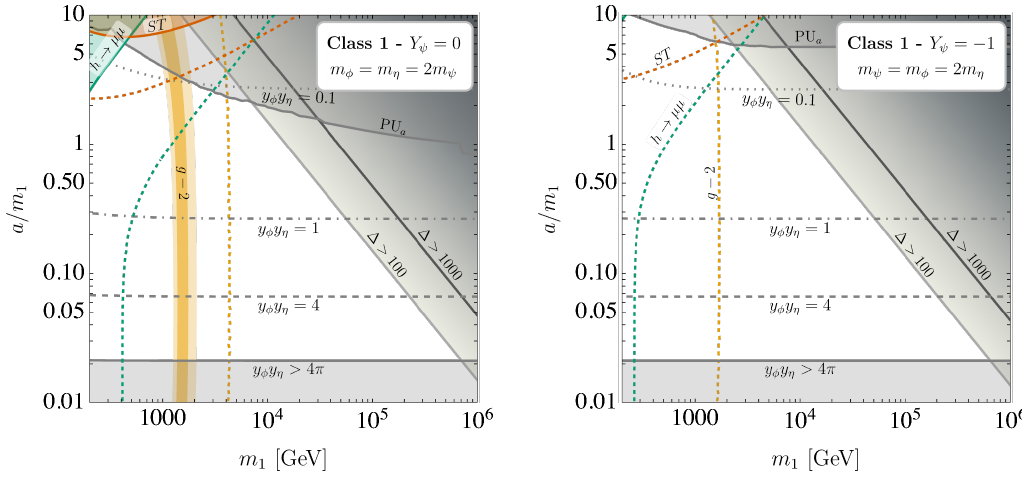
Figure 3 . Theoretical (grey) and experimental (coloured) constraints on the Class 1 benchmark models. The product of Yukawas required to reproduce the observed muon mass is shown by contours at y φ y η ∈ { 0 . 1 , 1 , 4 , 4 π } . The region where perturbative unitarity of the trilinear coupling is violated is indicated by PU a . The degree of fine-tuning is shown by contours at ∆ ∈ { 100 , 1000 } using the measure defined in [3]. The orange bands show the region that fits the ( g − 2) µ anomaly at 1 and 2 σ , while the green and red regions are experimentally excluded at 2 σ by the Higgs-muon signal strength and the S and T parameters, respectively. Coloured dotted contours show the corresponding 2 σ projected future